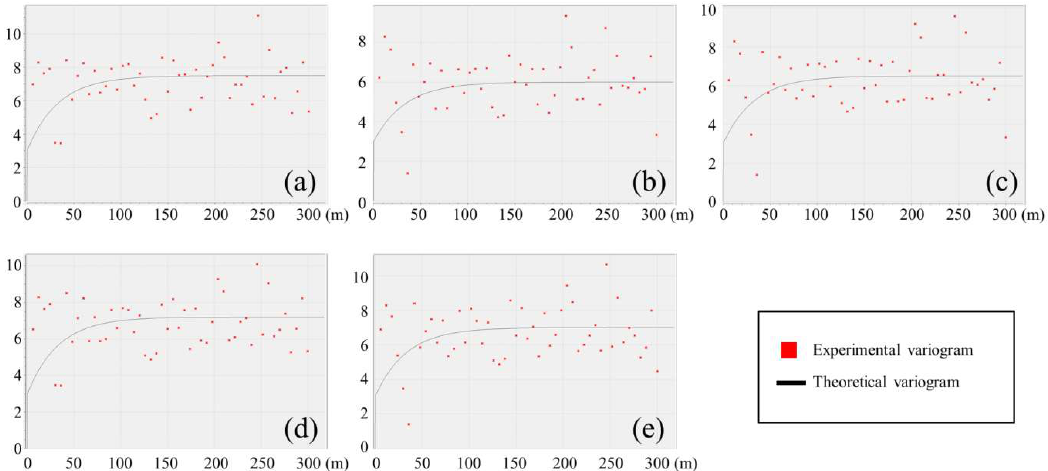
Figure 6. The experimental variogram and theoretical variogram for ( a ) all borehole data or capped data by ( b ) prob top-cut, ( c ) perc top-cut, ( d ) std top-cut, and ( e ) hot spot top-cut.